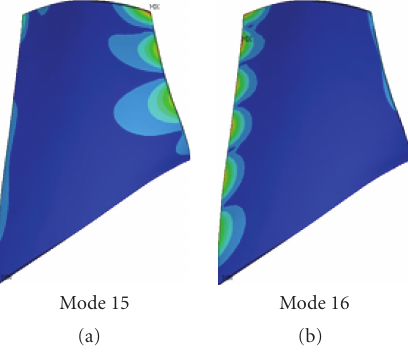
Figure 1: Mode fifteen and mode